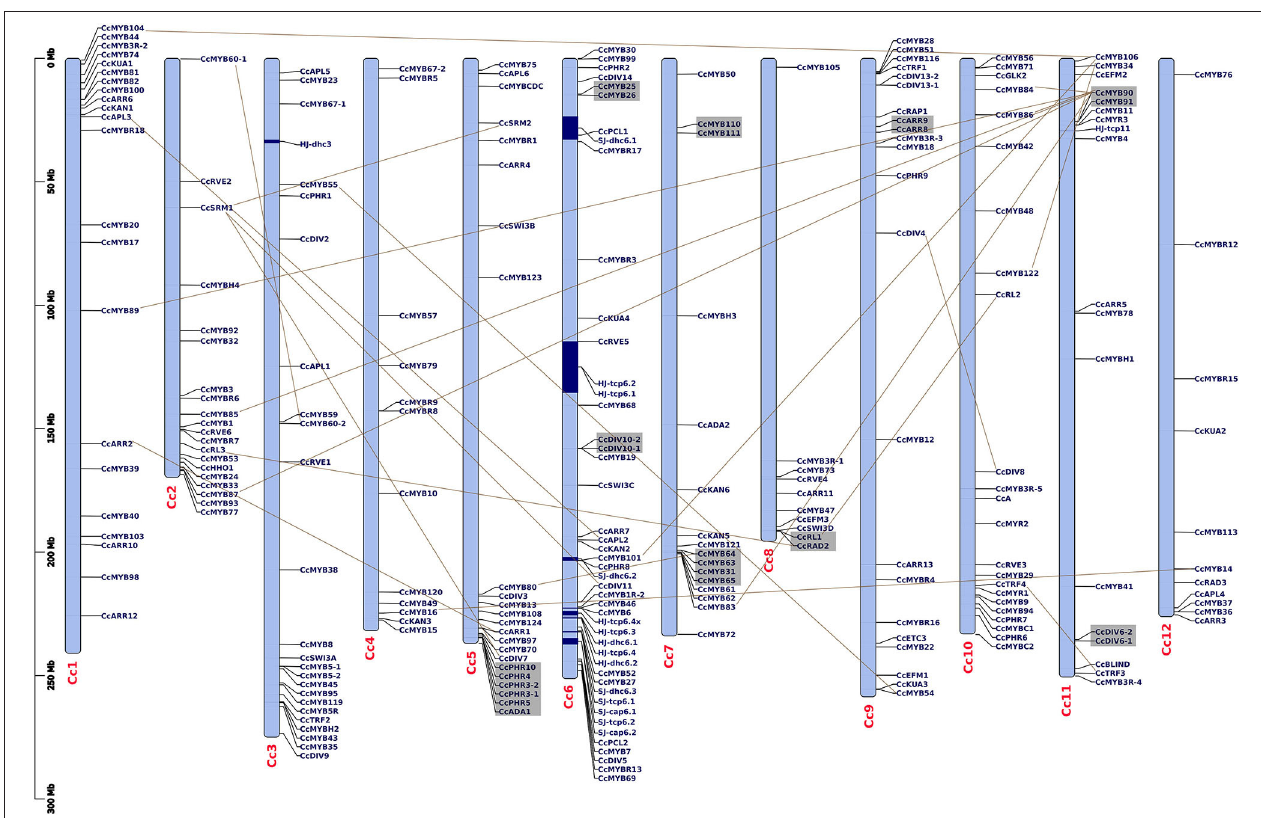
FIGURE 1 | Distribution of CcMYB genes on 12 Capsicum chromosomes along with the previously reported capsaicinoid QTLs (Han et al., 2018; Park et al., 2019). The QTLs are shown in blue blocks. The tandem duplicates are shown via gray blocks, while the segmental duplicates are shown via connecting lines. The scale is mentioned on the left of the chromosomes in million base pairs